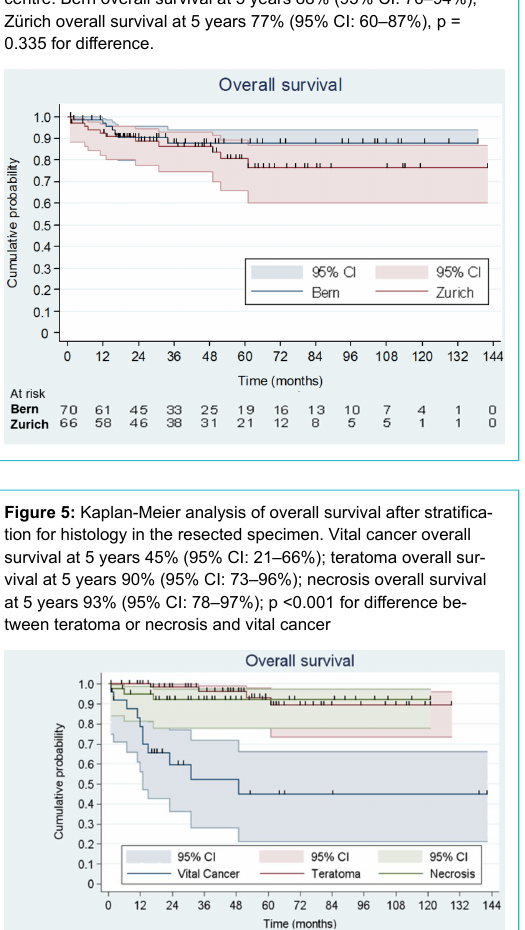
Figure 4: Kaplan–Meier analysis of overall survival probabilities by centre. Bern overall survival at 5 years 88% (95% CI: 76–94%),